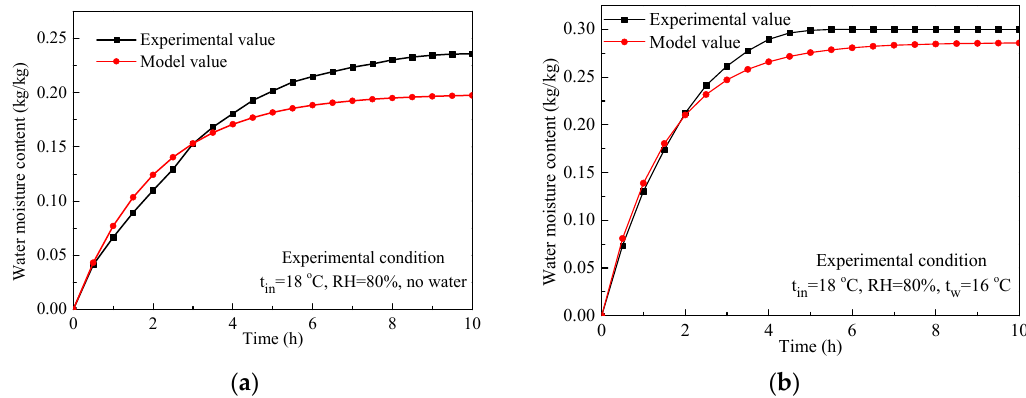
Figure 18. Comparison of the results from testing and calculated models on water content of solid desiccant: ( a ) without internal cooling; ( b ) with internal cooling